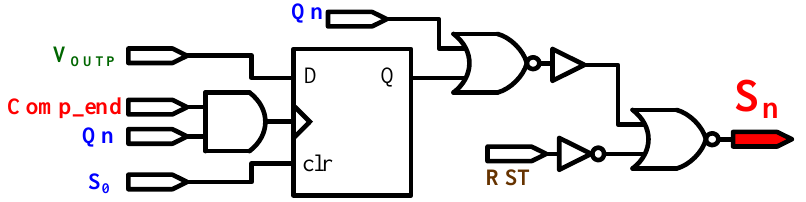
Figure 8. Signal generation circuit of DAC switch S n .